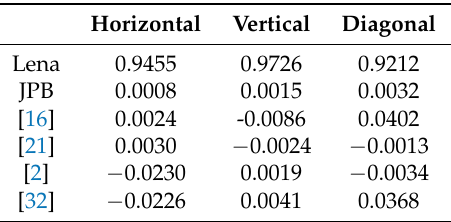
Table 3. Correlation coefficients of encrypted Lena using different